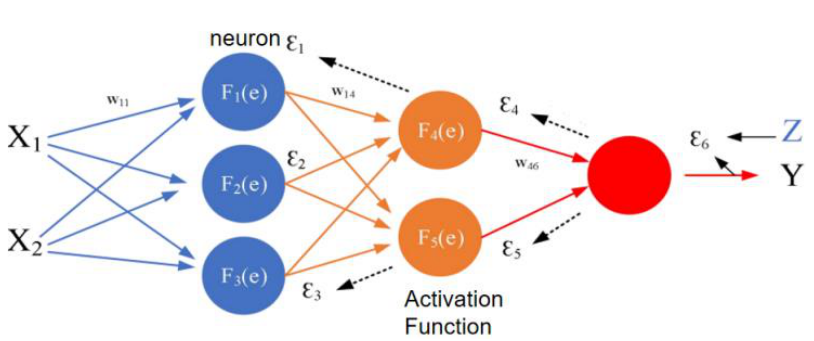
Figure 6. B ack p ropagation neural network construction reference. Figure 6. Back propagation neural network construction reference.